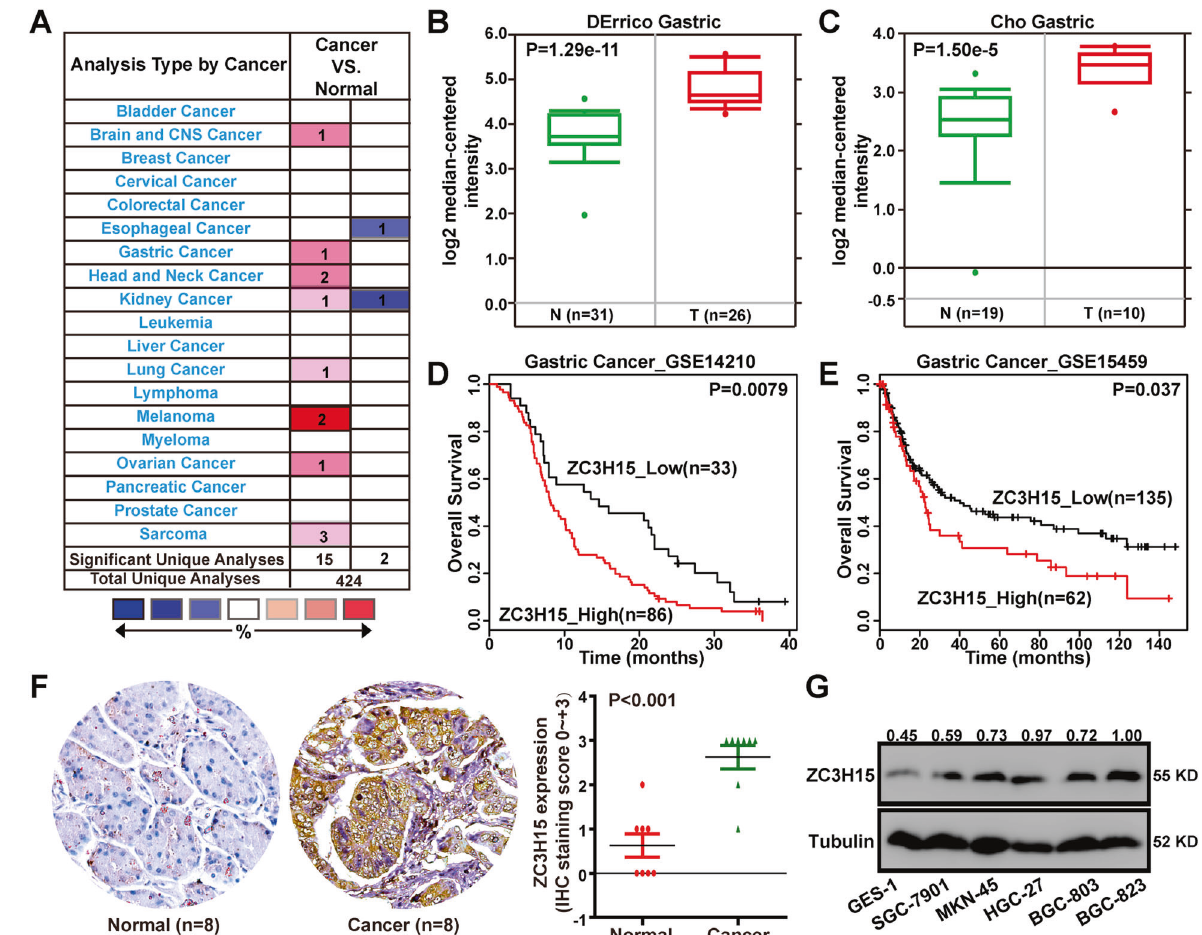
Fig. 1 ZC3H15 was upregulated in GC and high expression of ZC3H15 was correlated with poor patient prognosis. A Up-regulation of ZC3H15 was found in 8 of 20 cancer types. B , C The level of ZC3H15 mRNA was signi fi cantly increased from normal stomach tissues to gastric cancer tissues in DErrico and Cho dataset and P -values were indicated. D , E Kaplan – Meier analysis of overall survival using data from the GSE14210 and GSE15459 database and P -values were indicated. F Immunohistochemical analyses of ZC3H15 expression in eight paired samples of gastric cancer and normal stomach tissue, P < 0.001. The data were expressed as mean ± SD. Student ’ s t -test was performed to analyze signi fi cance. G Western blot analyses were used to examine ZC3H15 expression in GES-1 cells and gastric cancer cell